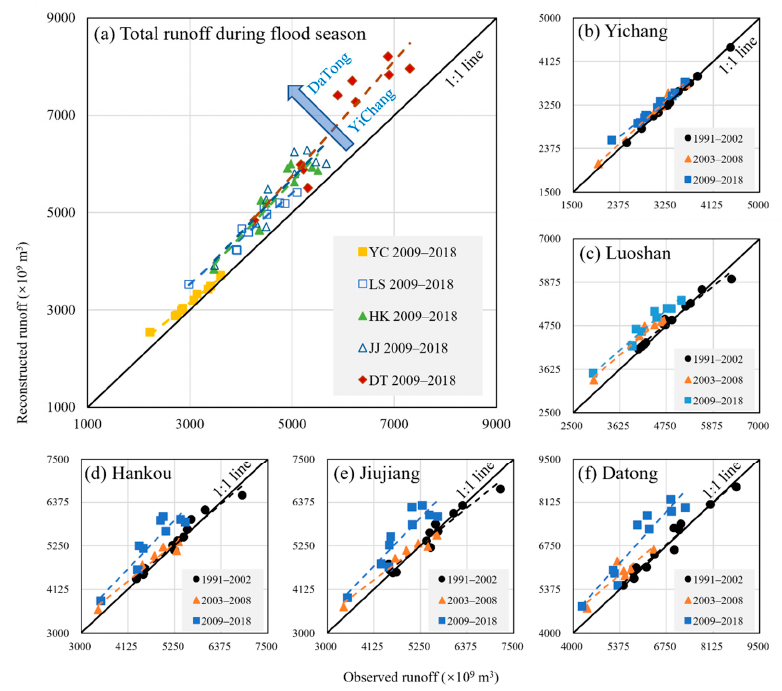
Figure 13. Comparison of the flood season runoff during flood season between the five gauging stations. If points are above the 1:1 line, the reconstructed runoff is greater than the observed runoff, and the TGD has reduced the flood season runoff. In contrast, if points are below the 1:1 line, the reconstructed runoff is less than the observed runoff, and the TGD has increased the flood season runoff.